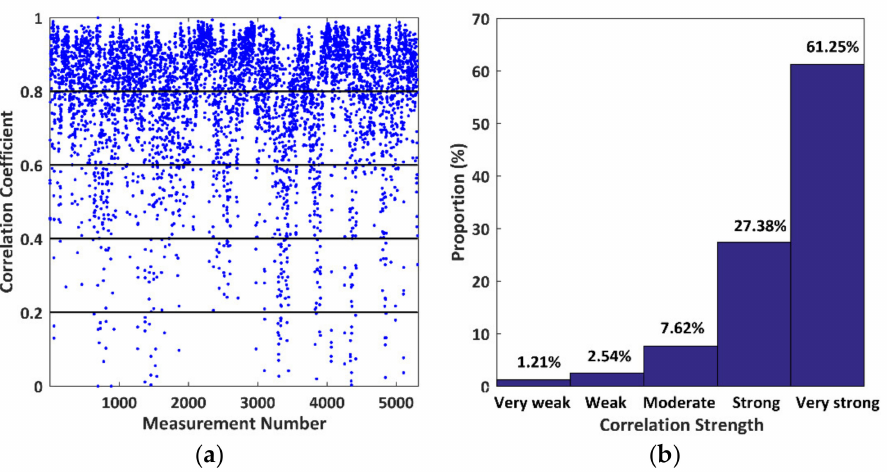
Figure 5. The correlation between Tomoradar waveforms and satellite lidar waveforms for 5321 measurements. ( a ) The correlation coefficients; ( b ) proportions classified by correlation